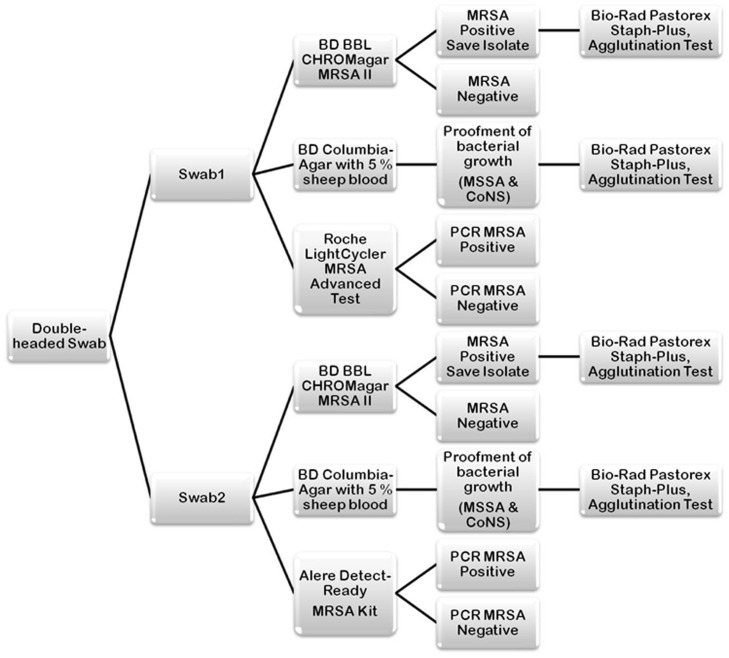
Clinical experimental design.Nasal/throat specimens were tested by Detect-Ready® MRSA Kit and by the LightCycler® MRSA Advanced Test. For testing, the double-headed swab was separated. One swab head was processed for directly plated culture on BD BBL™ CHROMagar™ MRSA Medium II, BD Columbia Agar with 5% sheep blood plates, and the LightCycler® MRSA Advanced Test. The other swab was used for the assay with Detect-Ready® MRSA Kit and directly plated culture on BD BBL™ CHROMagar™ MRSA Medium II, and BD Columbia Agar with 5% sheep blood plates. MRSA positive colonies onto the selective chromogenic agar were confirmed to be S. aureus using an agglutination test.